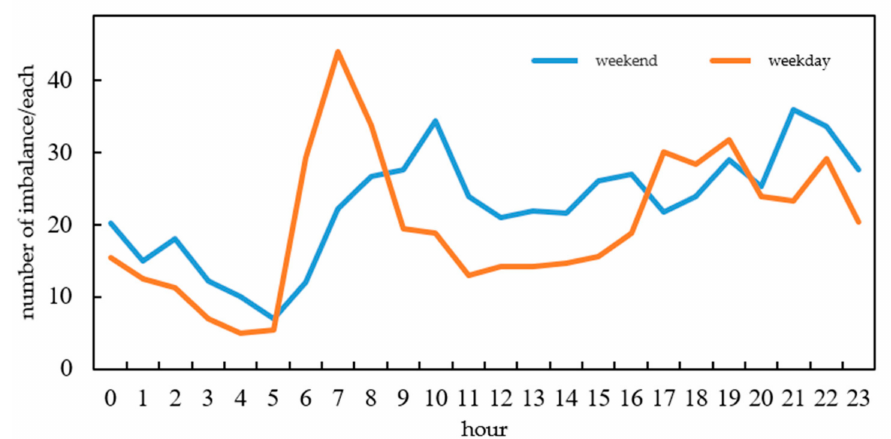
Figure 5. Cumulative imbalance of stations in each